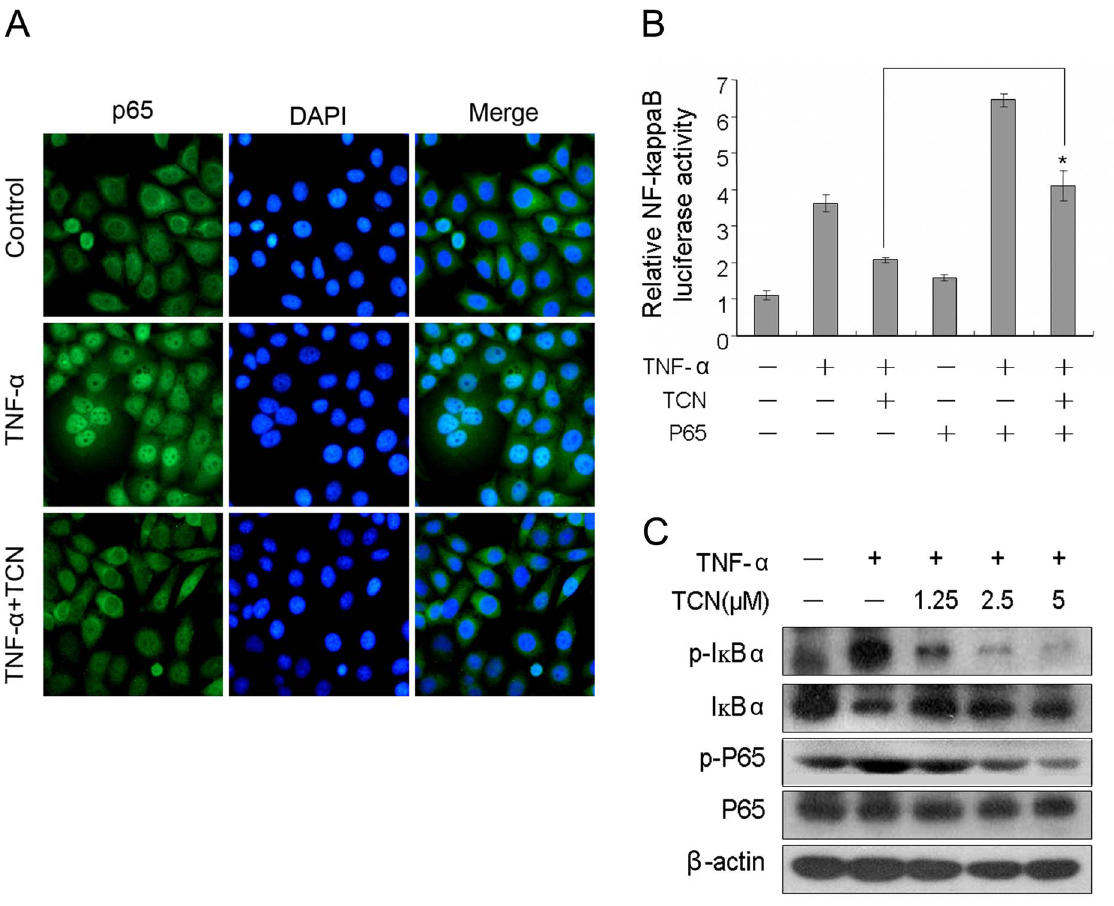
Figure 3. TCN blocks TNF- a induced p65 nuclear translocation and the phosphorylation of I k B a . (A) HepG2 cells pretreated with 2.5 m M TCN were stimulated with 25 ng/mL TNF- a for 20 min and processed for immunostaining with anti-p65 antibody. Nuclei of cells were stained with DAPI (blue) and p65 was visualized by green fluorescence. (B) HEK293T cells were transiently transfected with pNF- k B-Luc and p65 expression plasmids followed by pretreatment of 0.3 m M TCN and stimulation with 25 ng/mL TNF- a . Reporter activity was then measured. (C) HepG2 cells pretreated with TCN were collected after stimulation with 25 ng/mL TNF- a for 10 min. Cell lysates were then analyzed by western blot using antibodies against phospho-I k B a , phospho-p65 and I k B a . Experiments were done independently in triplicate and the results are reported as means and standard deviations. Statistical analysis was perform with Student’s t-test, *p , 0.05.